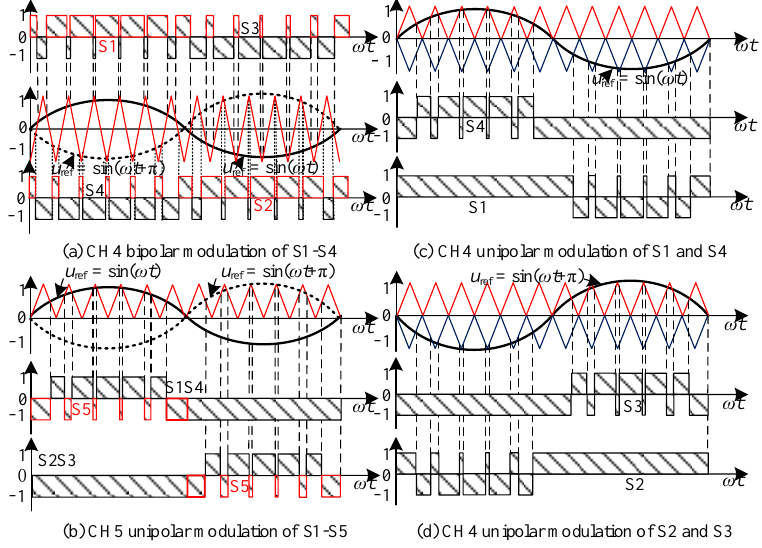
Figure 2. Comparison of modulation strategies: ( a ) VH4 bipolar modulation of S1–S4; ( b ) CH5 unipolar modulation of S1–S5; ( c , d ) CH4 unipolar modulation of S1–S4 and S2–S3. CH5 bipolar modulation: when S5 is turned on, the PV current i PV is stored through the DC side inductances L 1 and L 2 , which is recorded as state 0; when S1 and S4 are turned on at the same time, the energy stored by the DC side inductances L 1 and L 2 are released to the positive half cycle of the power grid, denoted as state 1; when S2 and S3 are turned on at the same time, the energy stored in the DC side inductors L 1 and L 2 are released to the negative half cycle of the power grid, denoted as state 1. When CH5 adopts bipolar